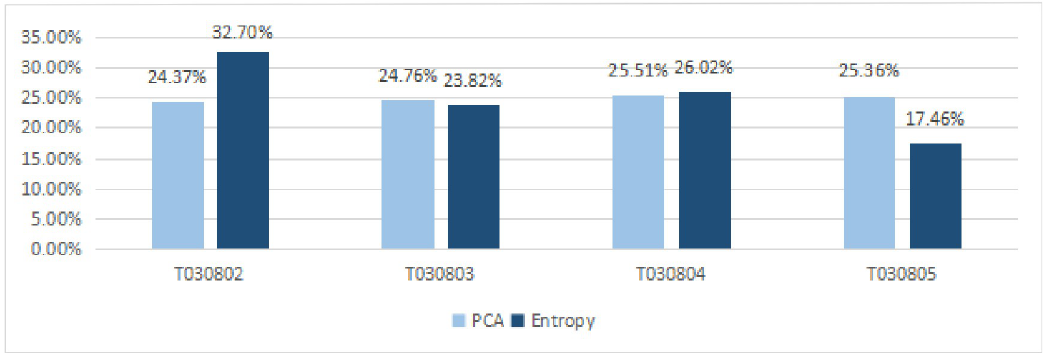
Fig 4. The computed outcomes of the weights in Case Study